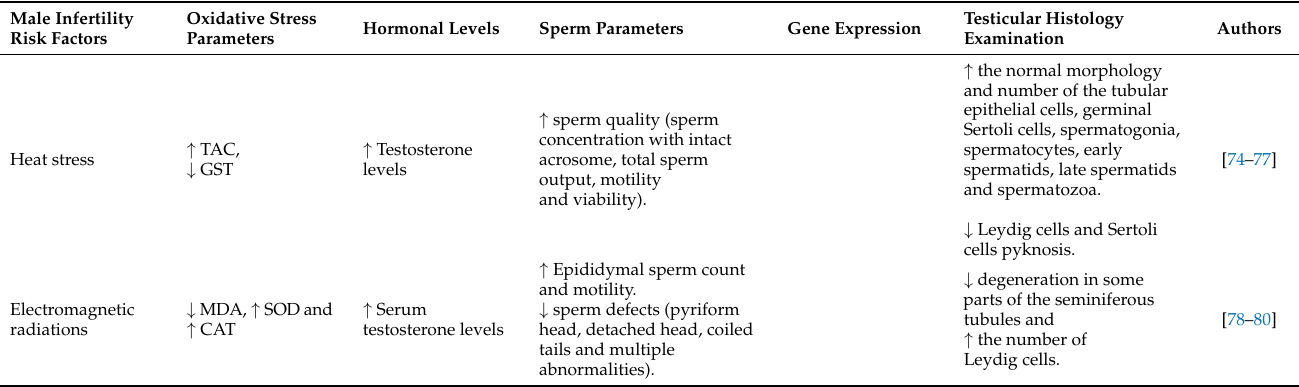
Table 1. Effects of M. oleifera leaves on damage induced by male infertility risk factors in the male reproductive